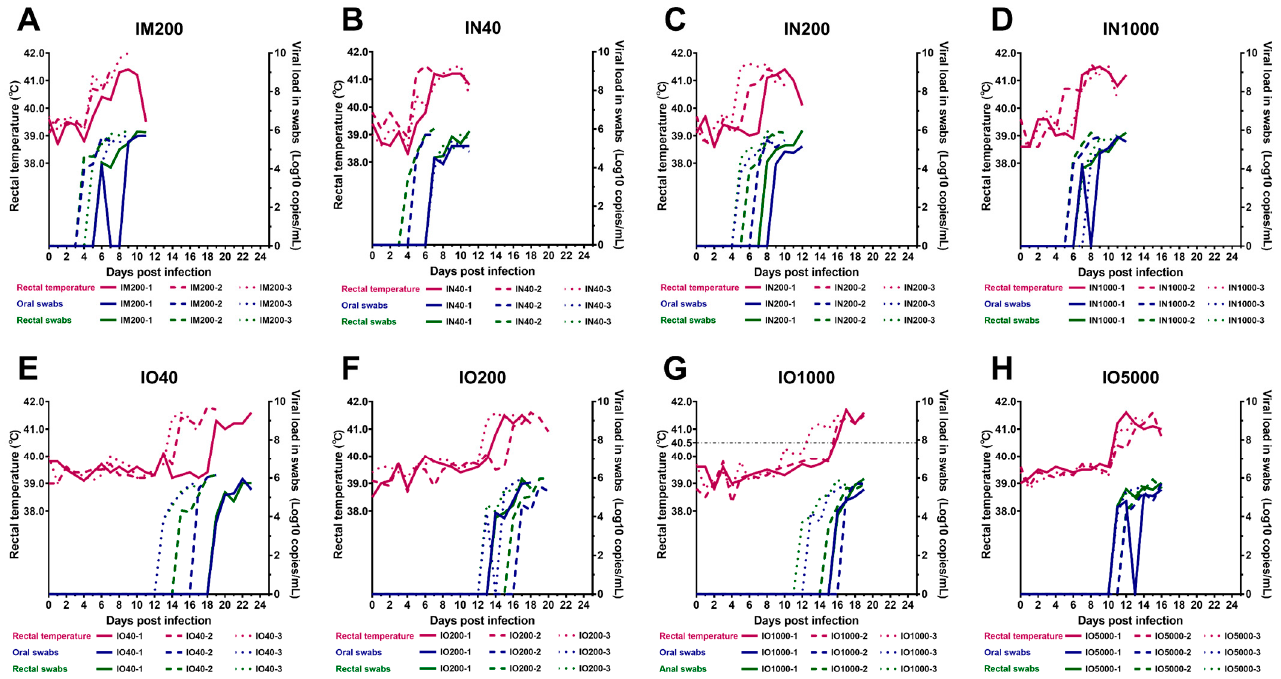
Figure 2. Results of rectal temperature and viral load in swabs for each group. ( A ) Inoculation of ASFV SY18 at 200 TCID 50 via the IM route; ( B – D ) Inoculation of ASFV SY18 at 40, 200, and 10,000 TCID 50 via the IN route; ( E – H ) Inoculation of ASFV SY18 at 40, 200, 1000, and 5000 TCID 50 via the IO route. The lines indicating rectal temperature (°C) are on the left Y-axis. The viral load in the swab (Log10 copies/mL) is indicated on the right Y-axis.